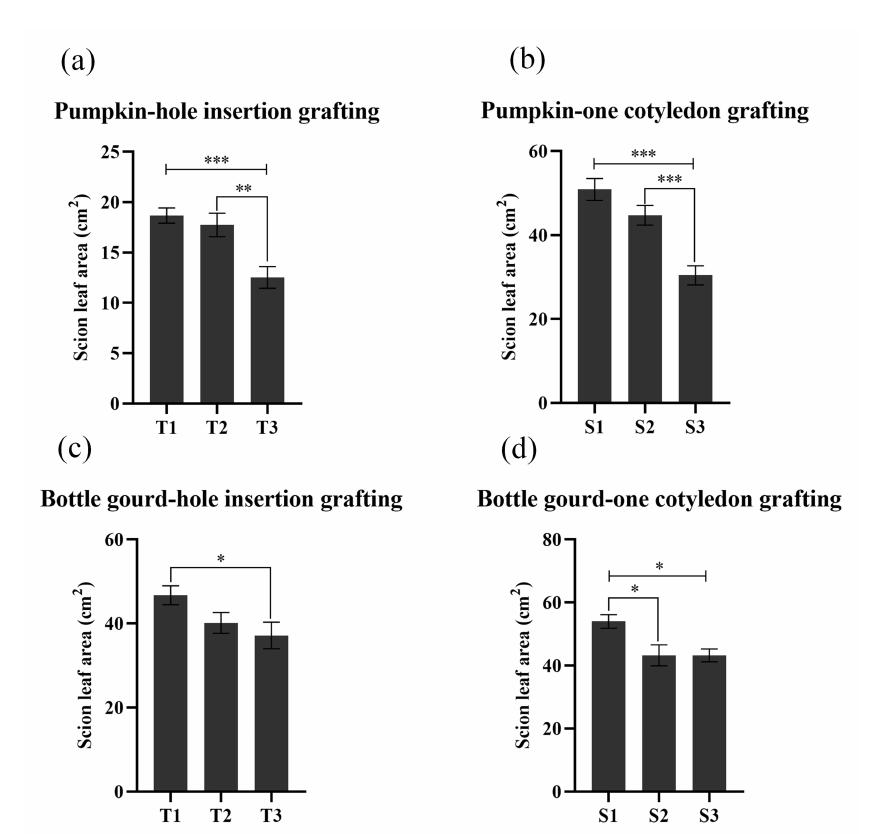
Figure 8. Watermelon scion leaf area at day 14 after grafting ( n = 3). T1 and S1, new “hole insertion grafting” ( a , c ) and “one cotyledon grafting” ( b , d ), respectively, without regrown rootstock removal; T2 and S2, traditional “hole insertion grafting” ( a , c ) and “one cotyledon grafting” ( b , d ), respectively, with manual regrown rootstock removal 3 times; T3 and S3, traditional “hole insertion grafting” ( a , c ) and “one cotyledon grafting” ( b , d ), respectively, without regrown rootstock removal. *, **, and *** indicate significant differences at p < 0.05, 0.01, and 0.001 levels.